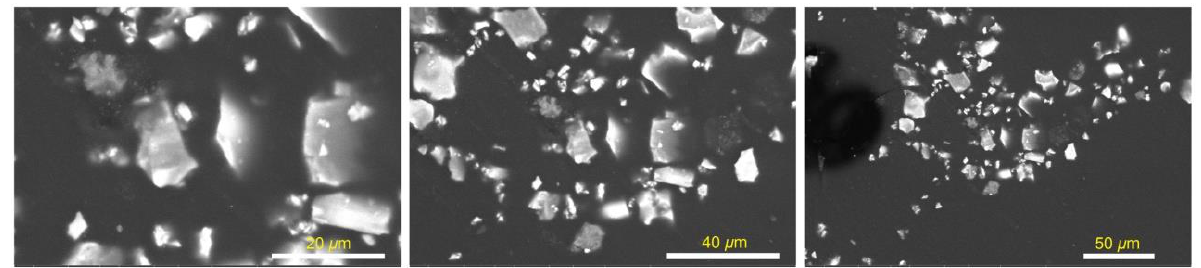
Figure 5. SEM images of PCP-16 at various enlargements.